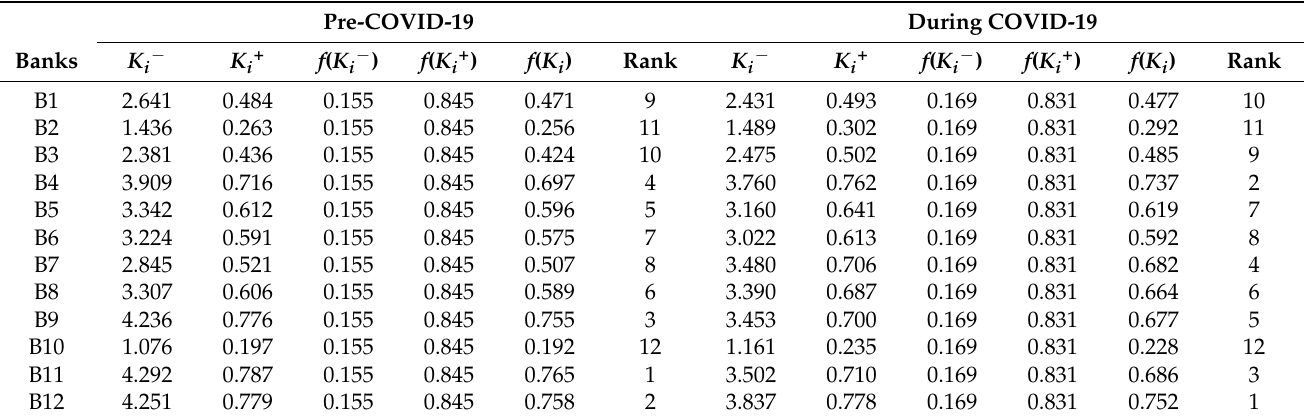
Table 16. The bank productivity ranking pre- and during